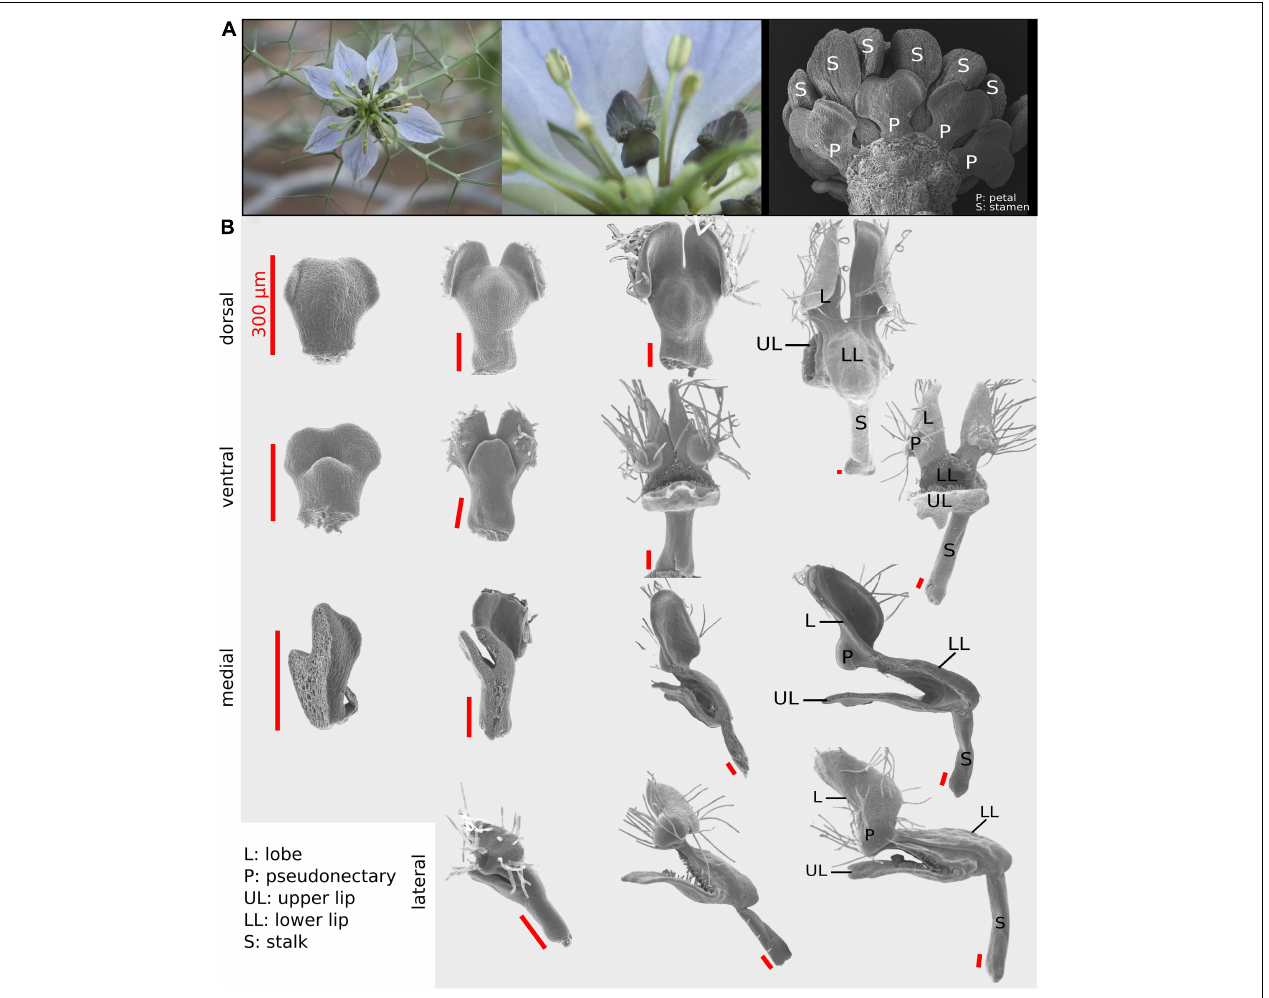
FIGURE 1 | The Nigella damascena petal and its developmental sequence. (A) Wild-type flowers of N. damascena comprise 7–9 petals. (B) Four views have been used to recapitulate petal morphogenesis: dorsal, ventral, medial, and lateral. On every column, petals are approximately at the same developmental stage. First column petals are taken after the restart of petal development (which undergoes a stasis after petal primordia formation). In the last column, petal morphogenesis is almost complete and all elaborations are